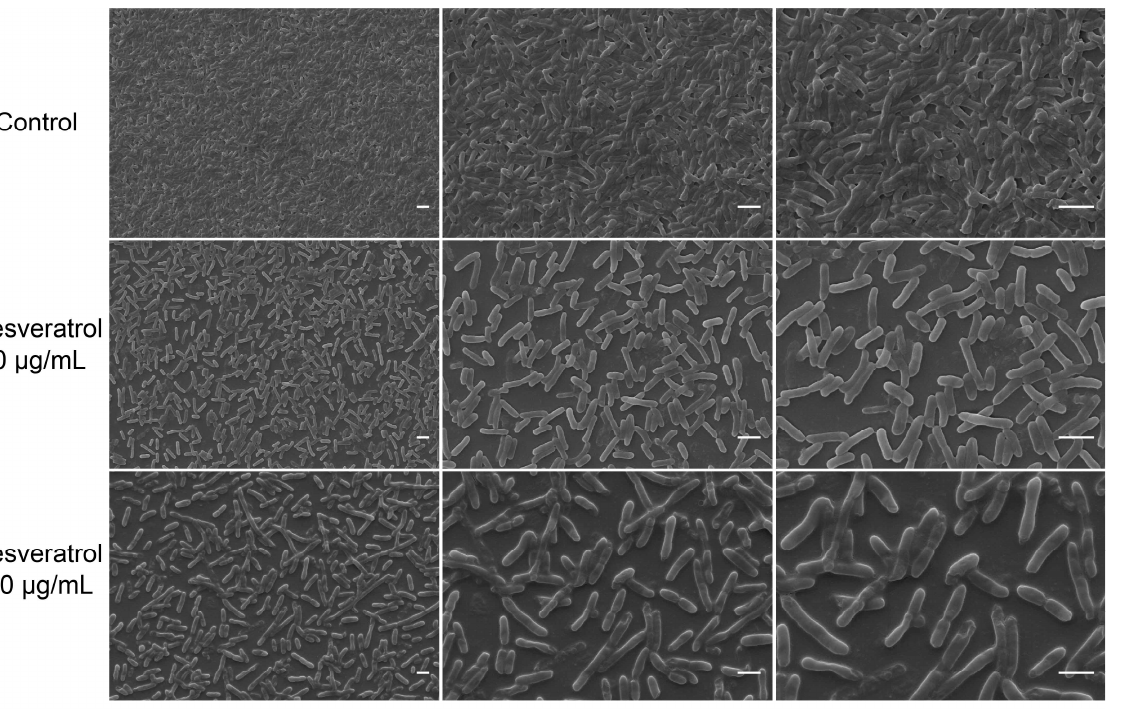
Figure 2. Scanning electron micrographs (SEM) of biofilm formed by A. hydrophila with different concentrations of resveratrol. Bars, 2 μ m at magnification 2000 ( left ), 4000 ( medial ), and 6000 ( right ).